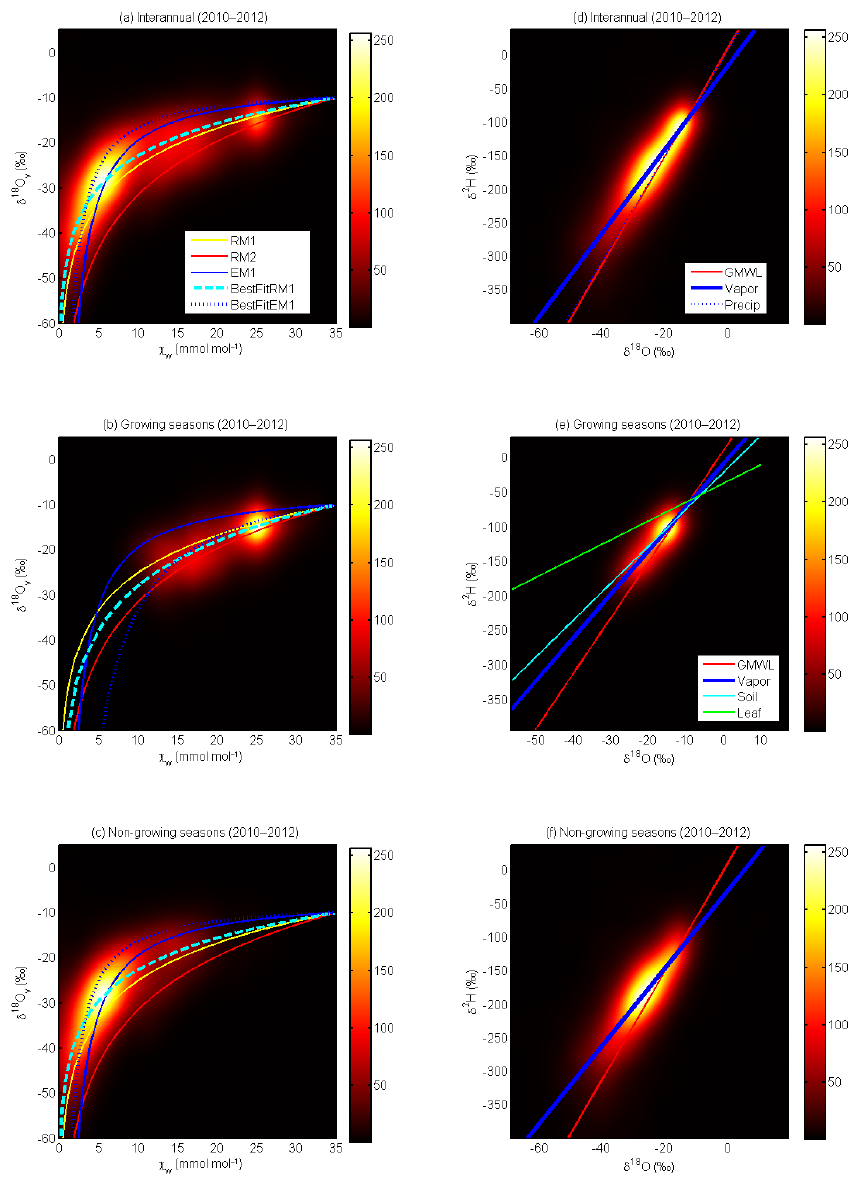
Figure 4. Smoothed histogram plots of oxygen and deuterium isotope ratios in water vapor from 2010 to 2012. Panels (a–c) illustrate oxygen isotope ratios in water vapor as a function of water vapor mixing ratio measured at a height of 185m on the University of Minnesota tall tower for (a) all years, (b) the growing season, and (c) the non-growing season. Panels (d–f) show isotope ratios in water vapor, soil water, and local leaf water plotted in δ 18 O– δ 2 H space for (d) all years, (e) the growing season, and (f) the non-growing season. The lines represent different models and parametrizations (RM1, RM2, and EM1) as described in the text. Color bars indicate the number of